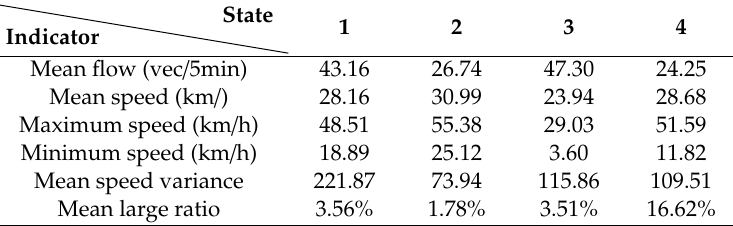
Figure 7. Frequency statistics of each state. Table 3. Analysis of the mean value of the evaluation indicators for each